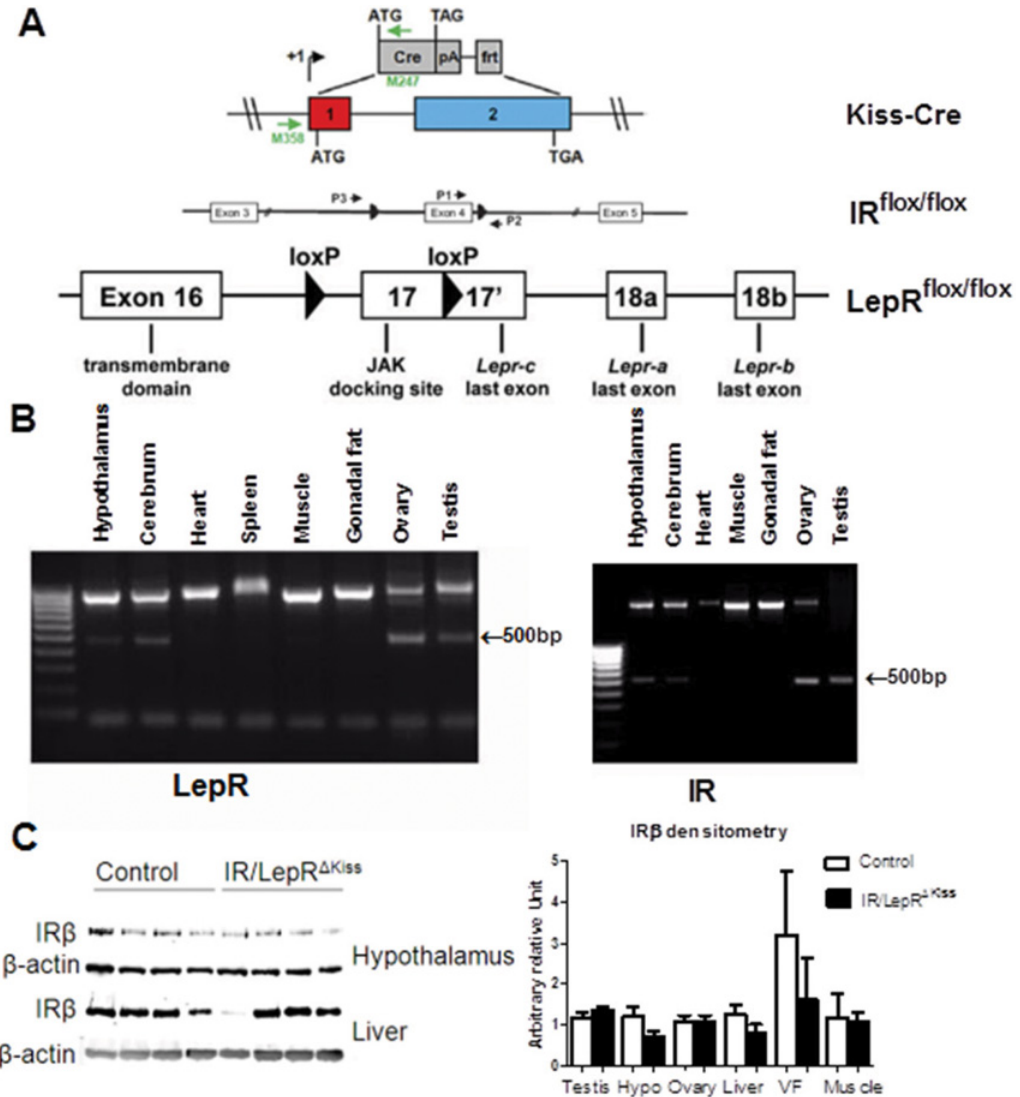
Fig 4. Generation of IR/LepR Δ Kiss mice. (A) Construct in making IR/LepR Δ Kiss mice. Adapted from previous publications [48, 50, 81]. (B) PCR of DNA from different tissues. The exercised LepR and IR both appear as a 500bp band, whereas unexercised LepR shown as 1kb band and unexercised IR as a 2.2kb band. (C) Representative IR β expression in different tissues and